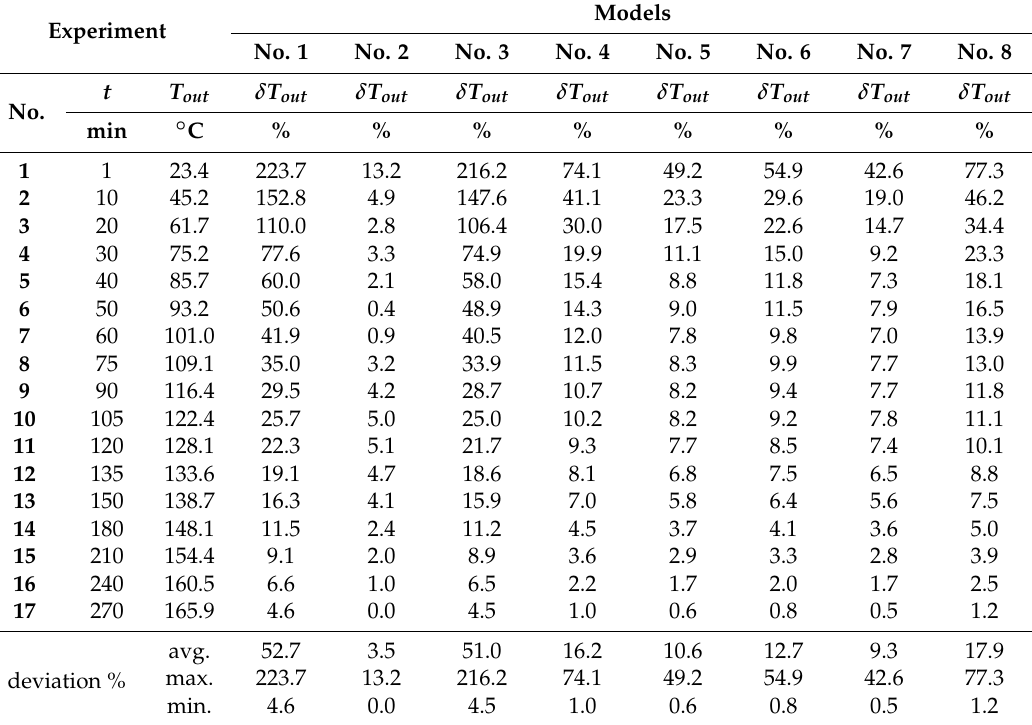
Table 6. Deviations for the airflow of 0.0068 m 3